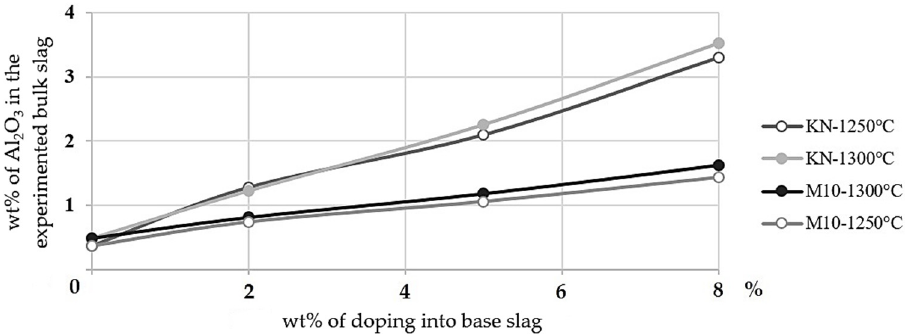
Figure 15. Alumina content in the bulk slag measured by ICP-OES v/s doping content at 1250 and 1300 °C.